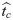
Seven dt-Violin plots of tc^ for the S&P 500 1987 bubble.(A) tend = 1987.06.25. (B) tend = 1987.08.06. (C) tend = 1987.10.15. Each panel is associated with the seven values of q = 0.05, 0.10, 0.20, 0.30, 0.50, 0.80, 0.90. Each dt-Violin plot is constructed over the statistics obtained over the set {dt = 750, 745, …, 125 trading days}. The black dashed horizontal lines in each panel indicates tend. The red dashed horizontal line shows the Tc = 1987.10.19.